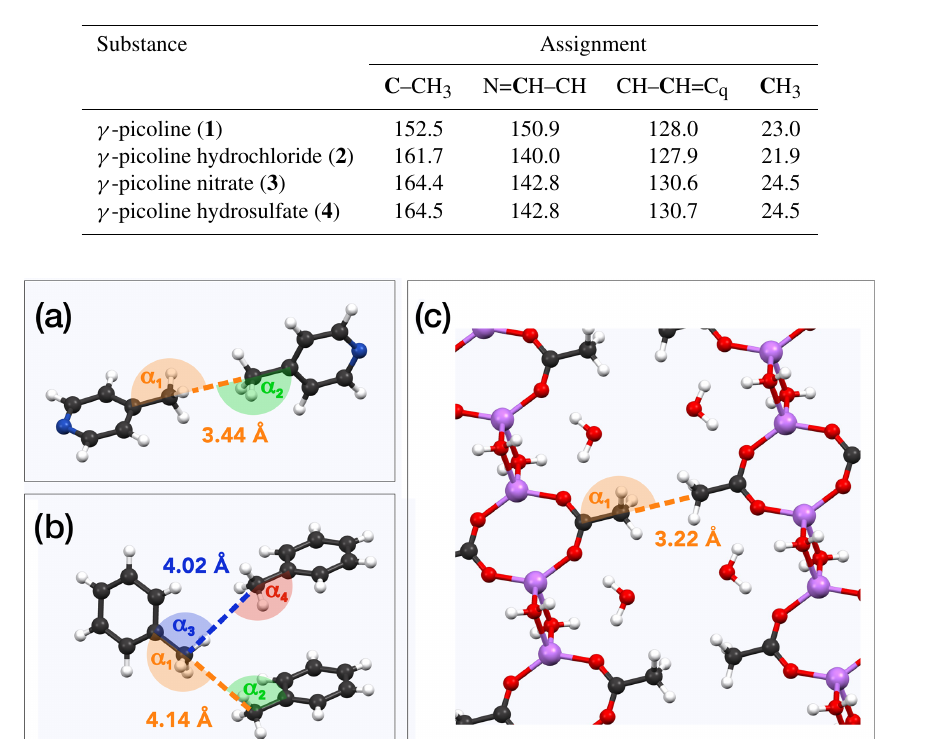
Table 2. 13 C NMR reference spectra of γ -picoline and its derivatives recorded on a Bruker Fourier 300 spectrometer. D 2 O was used as solvent. The chemical shifts are given in parts per million (ppm).